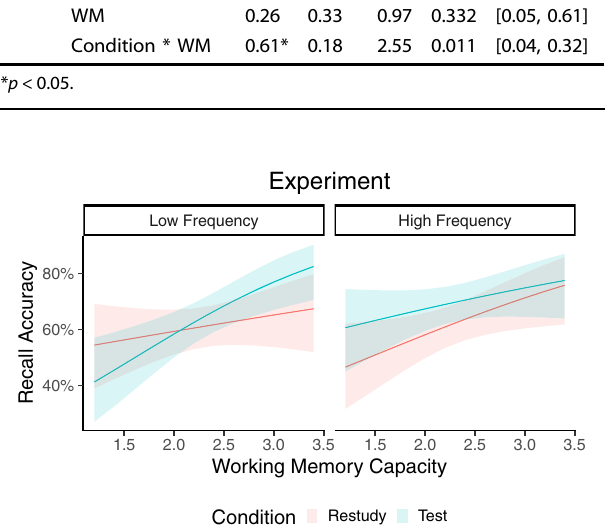
Fig. 2 Predictions of the fi nal test accuracy based on the mixed- effects logistic regression models. While all participants showed the testing effect in HF associations, only participants with higher WM capacity showed the testing effect in LF associations. The shaded areas represent the 95% con fi dence intervals for the fi tted regression